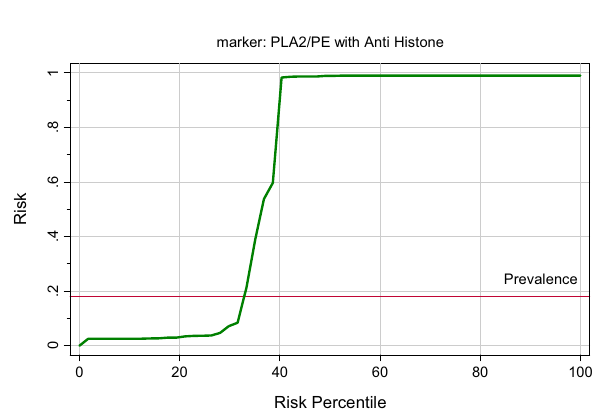
Figure 7. Predictiveness curve of combining of the two parameters for patient